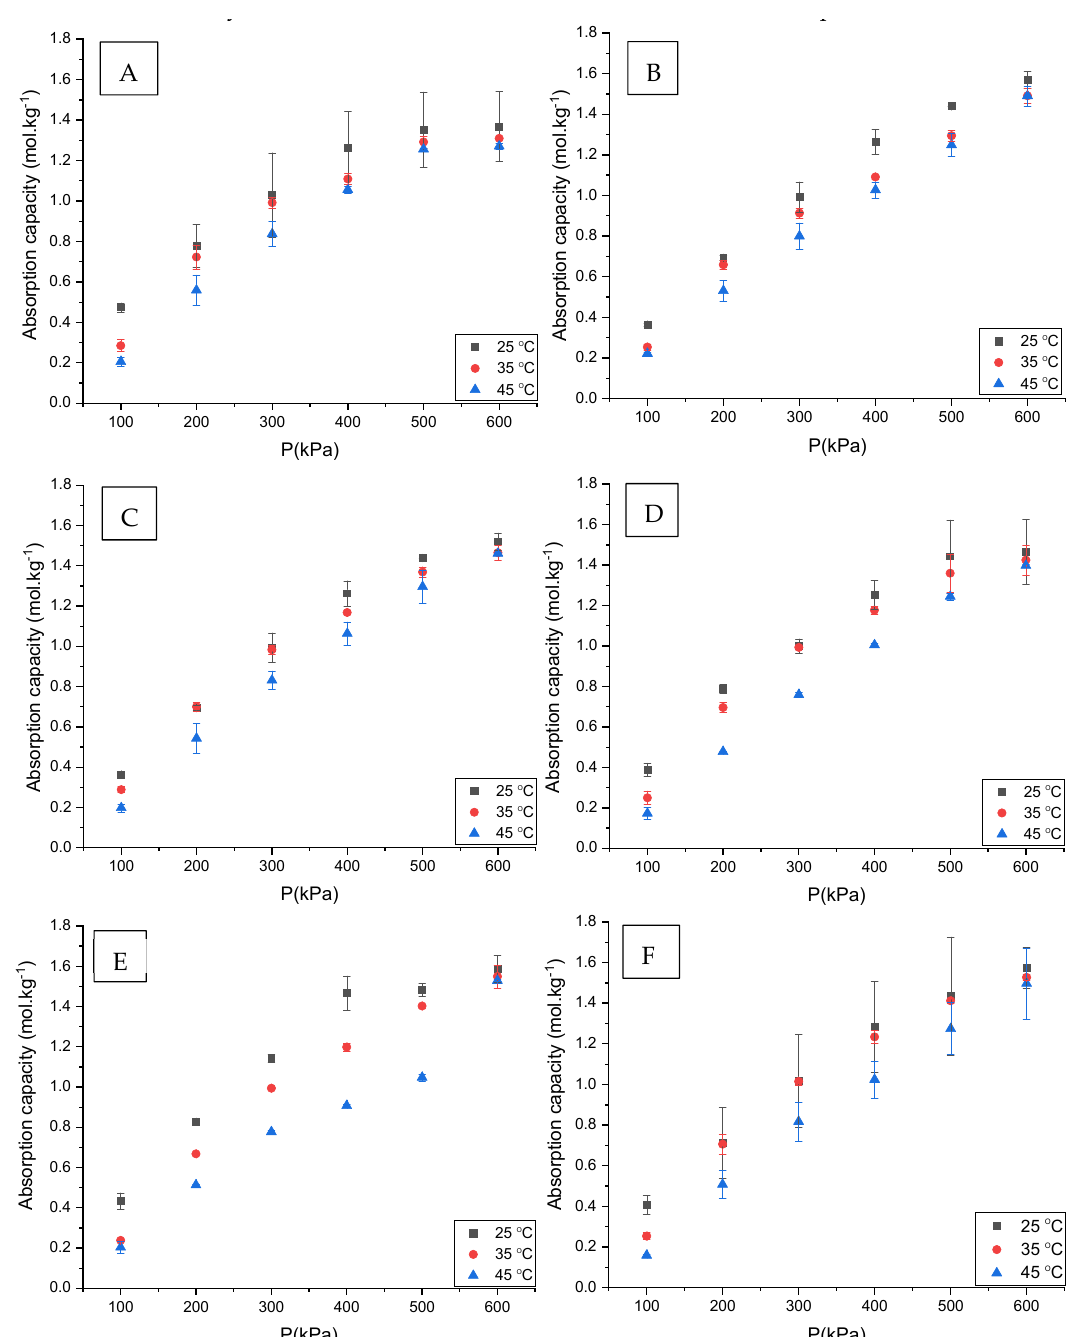
Figure 2. CO 2 absorption capacity of ChCl:LvAc DESs with different compositions at temperatures ranging from 25 °C to